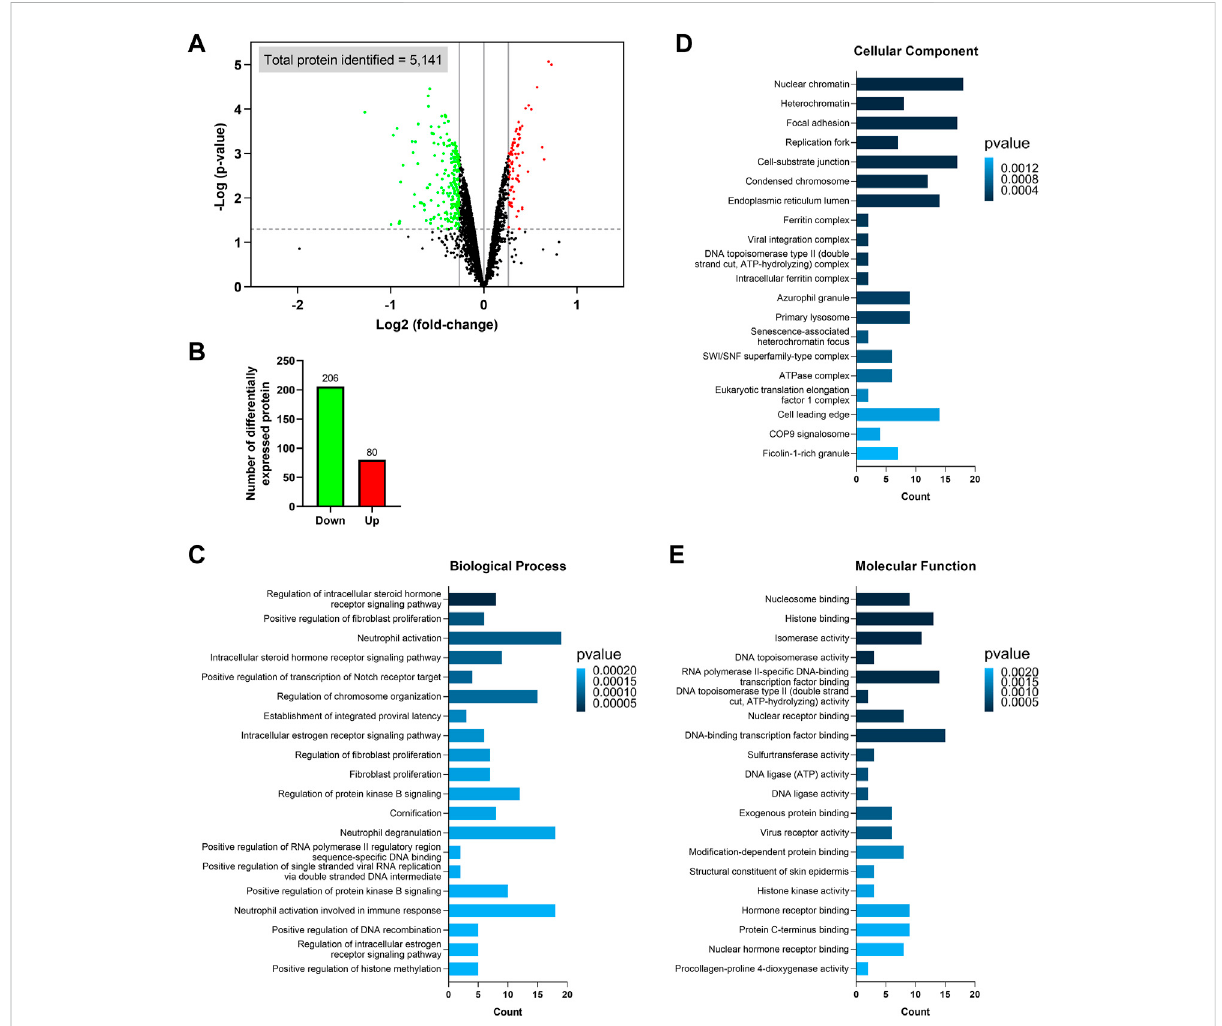
FIGURE 2 Identi fi cation of differentially expressed proteins and Gene Ontology (GO) enrichment analysis. (A) Volcano plot showing the differentially expressed proteins identi fi ed in the ZIP8-KO cells. Only proteins with p ≤ 0.05 and expression fold-change ≥ 1.2 or ≤ − 1.2 are considered signi fi cant, and these proteins are highlighted in green (downregulated) or red (upregulated). Vertical lines on the x-axis represent 1.2 or − 1.2 fold-change; dash line on y-axis represents p = 0.05. (B) Number of upregulated and downregulated proteins. (C – E) GO enrichment analysis of the differentially expressed proteins classi fi ed based on biological process (C) , cellular component (D) , and molecular function (E)